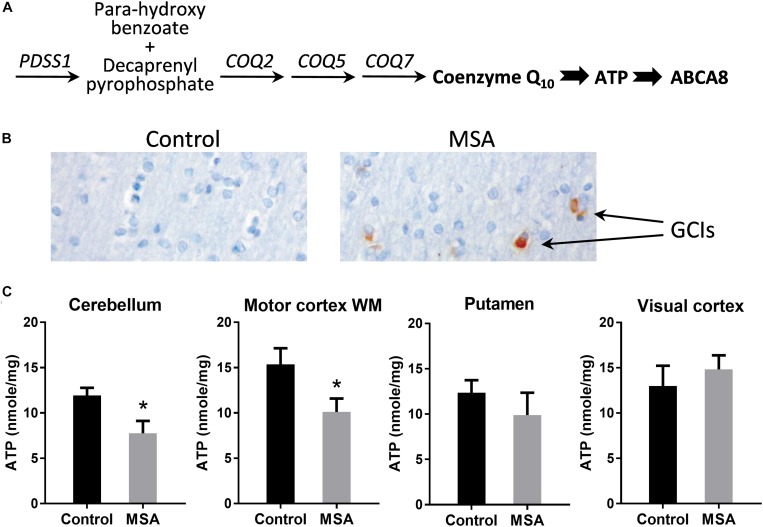
ATP levels in MSA and control brains. (A) The biosynthetic pathway of coenzyme Q10 and its downstream markers, ATP and ABCA8. (B) Immunohistochemistry of cells in the white matter underlying motor cortex using α-synuclein antibody and Nissl staining. (C) ATP levels in disease-affected regions (cerebellum, white matter underlying motor cortex and putamen) and disease-unaffected region (visual cortex) of MSA (n = 8) and control (n = 10) brains. Data represent mean and SE as error bars, ∗p < 0.05.